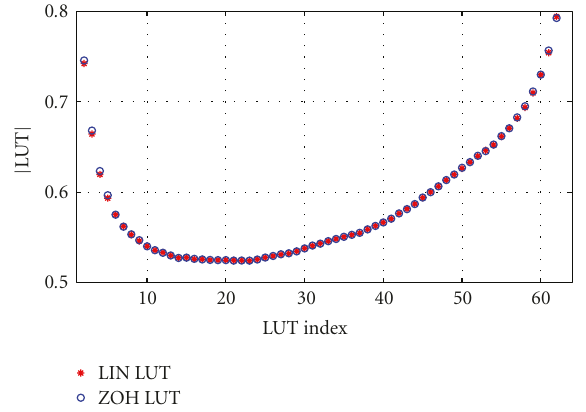
Figure 10: Converged LUT Predistorters using LCNLMS with linear (LIN) and nearest-neighbor (ZOH) interpolation in the feedback predistorter.